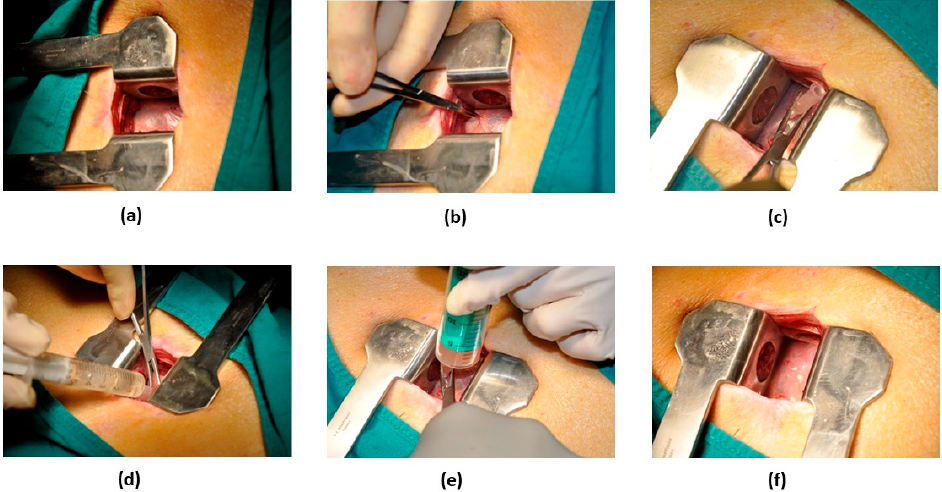
Figure 2. Surgical procedure for IP therapy. ( a ) Exposure of the pericardial sac through a 5-cm-long incision in the fourth or fifth intercostal space. ( b ) Gentle traction of the pericardium to allow puncturing and to gain access to the pericardial cavity. ( c ) Placement of an 18G Abbocath catheter within the pericardium. ( d ) Evacuation of pericardial fluid. ( e ) Slow injection of the therapy through the catheter. ( f ) Appearance of the pericardium after catheter removal.